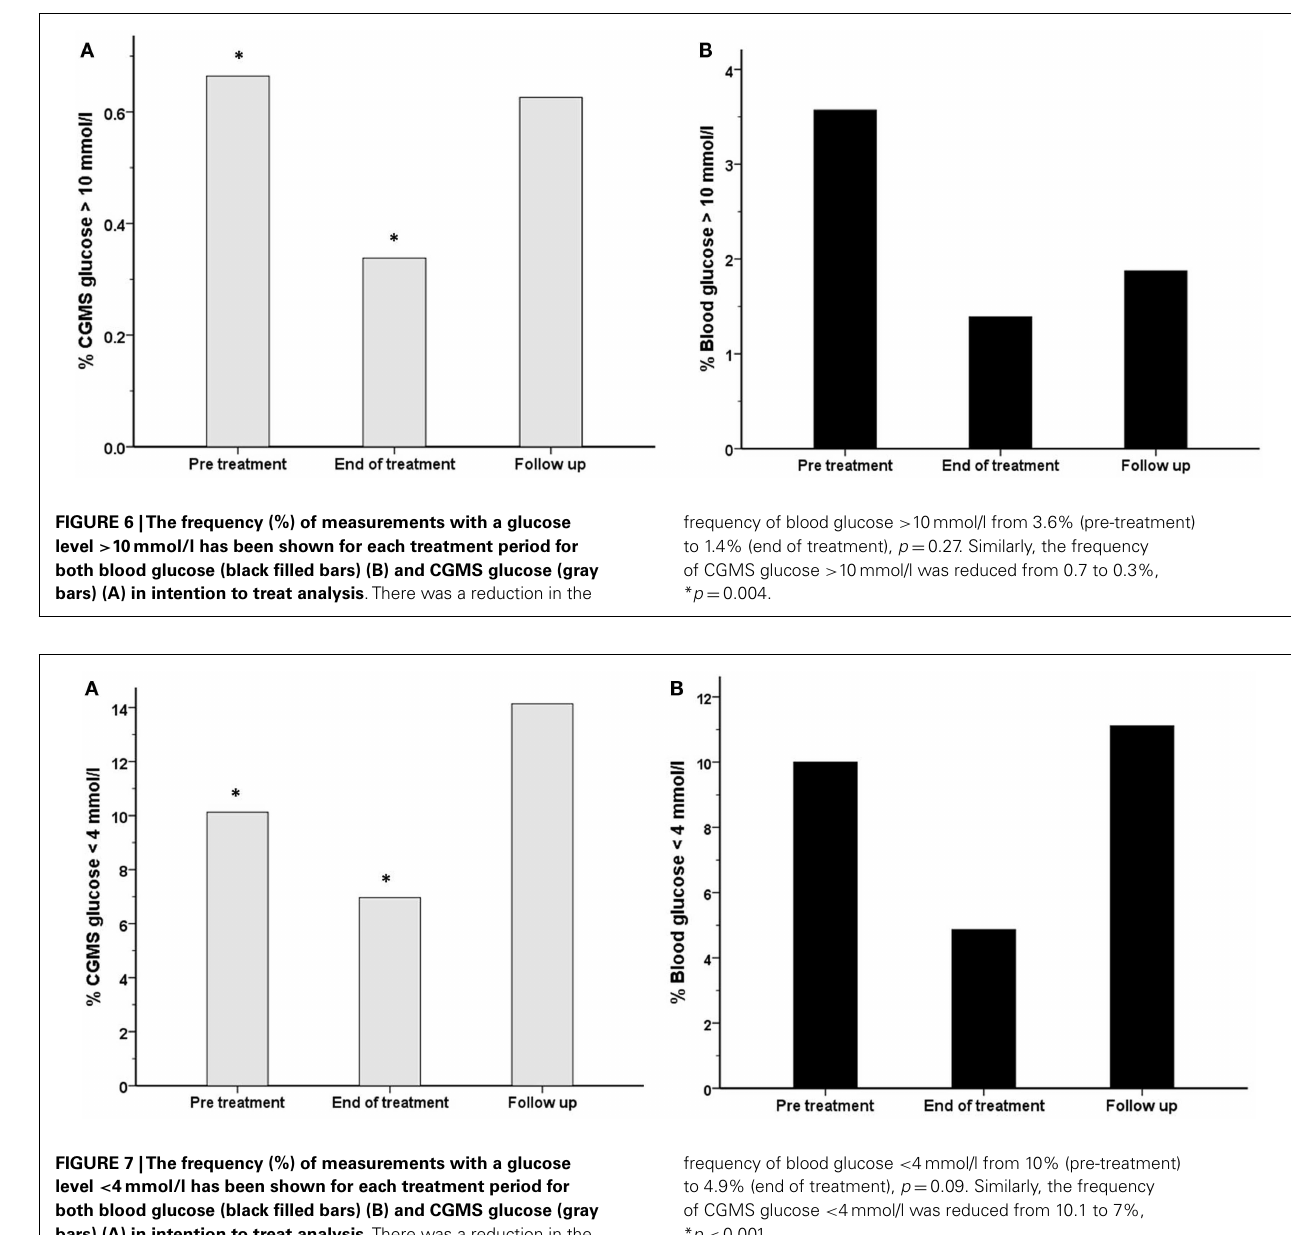
FIGURE 7 |The frequency (%) of measurements with a glucose level < 4mmol/l has been shown for each treatment period for both blood glucose (black filled bars) (B) and CGMS glucose (gray bars) (A) in intention to treat analysis .There was a reduction in the